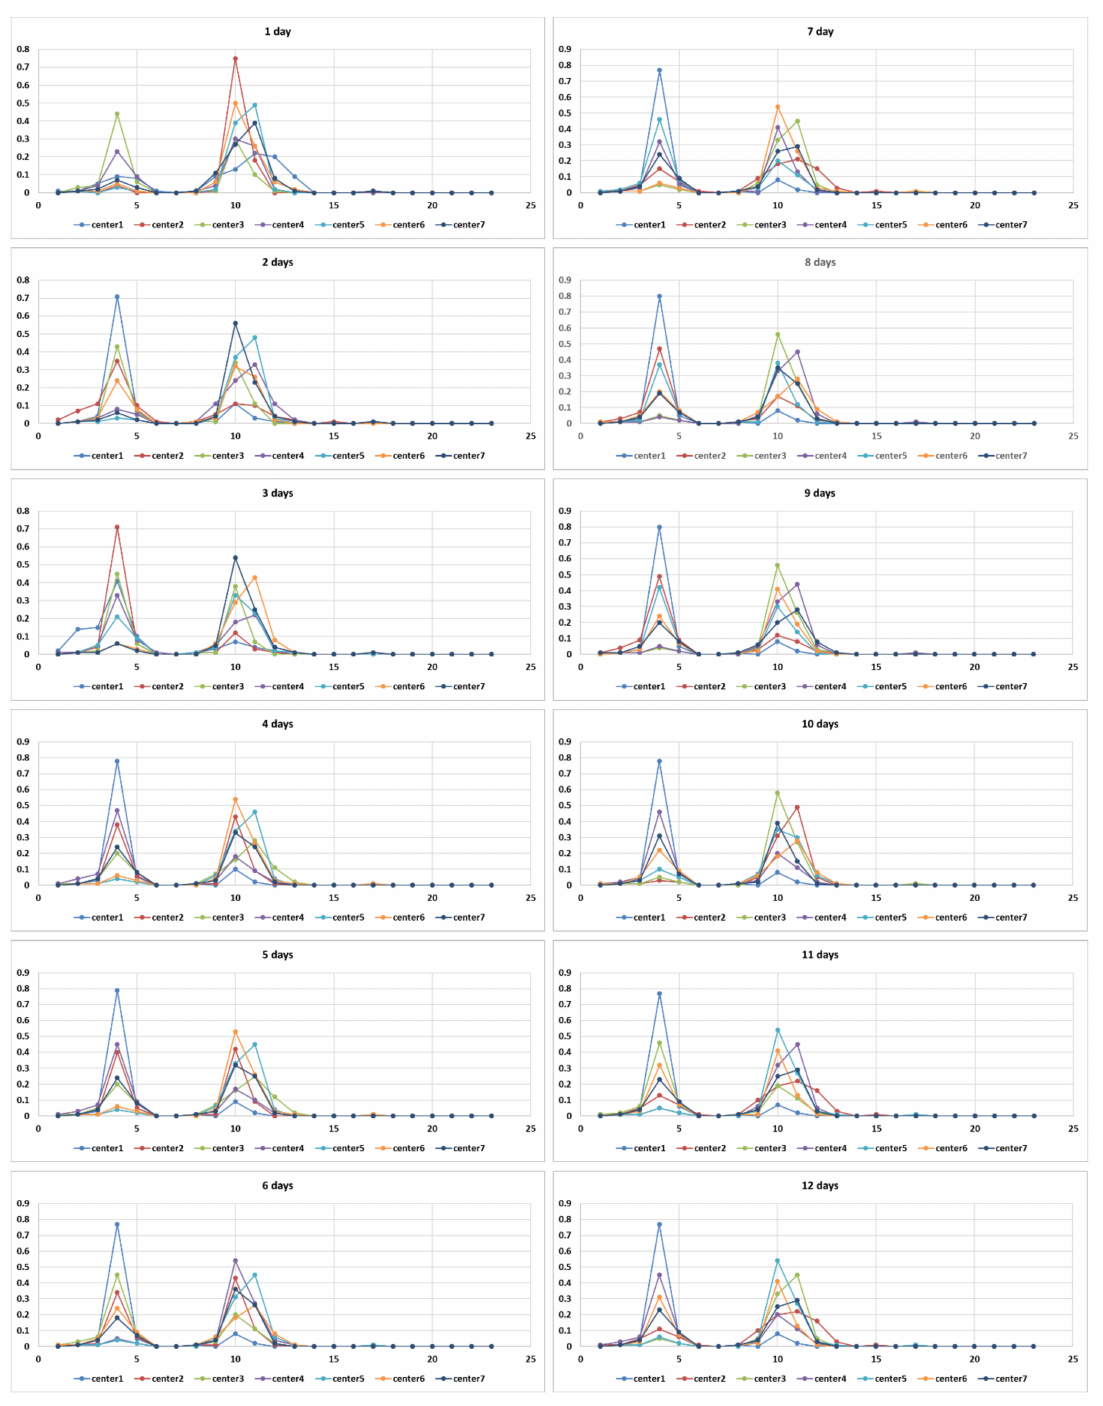
Figure 4. OpMode Distributions of Cluster